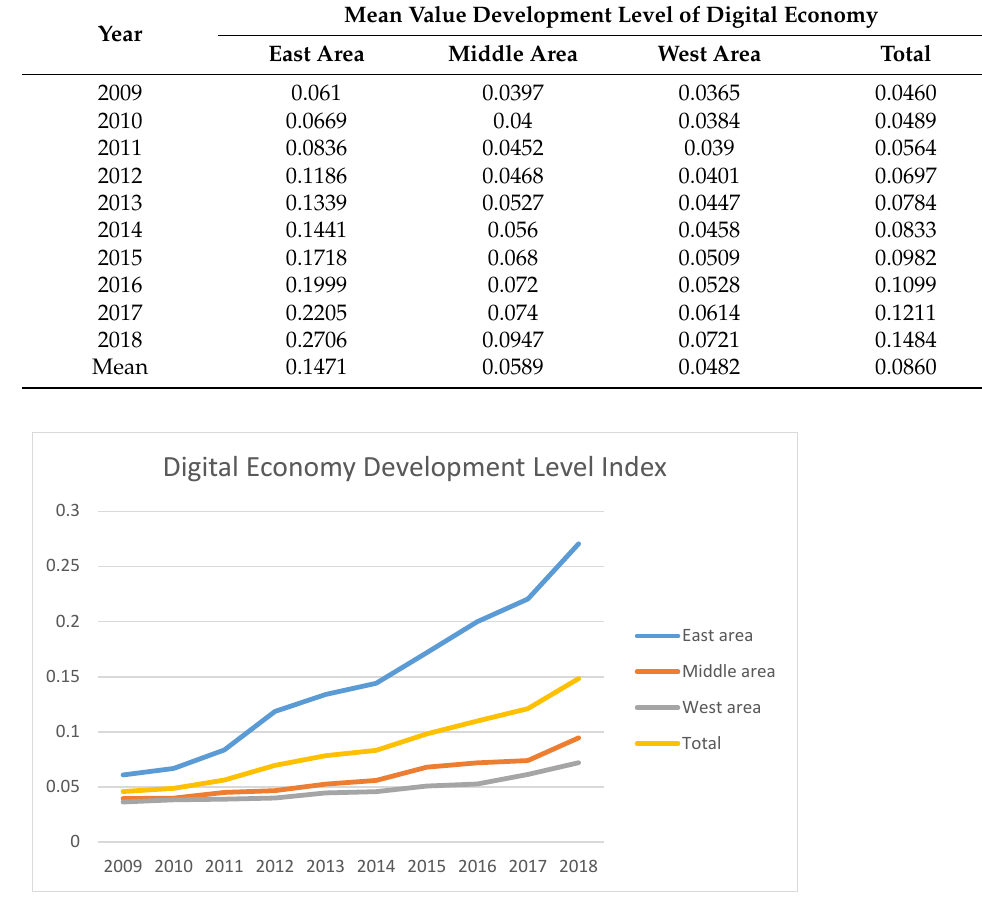
Figure 1. Mean value of the development level of digital economy in eastern, middle and western areas.